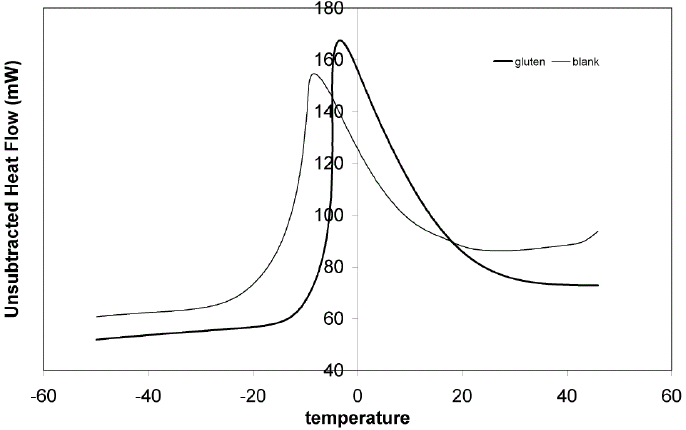
Figure 5. Differential Scanning Calorimetry (DSC) diagrams comparison between samples made from white flour supplemented with 6% gluten and control samples.